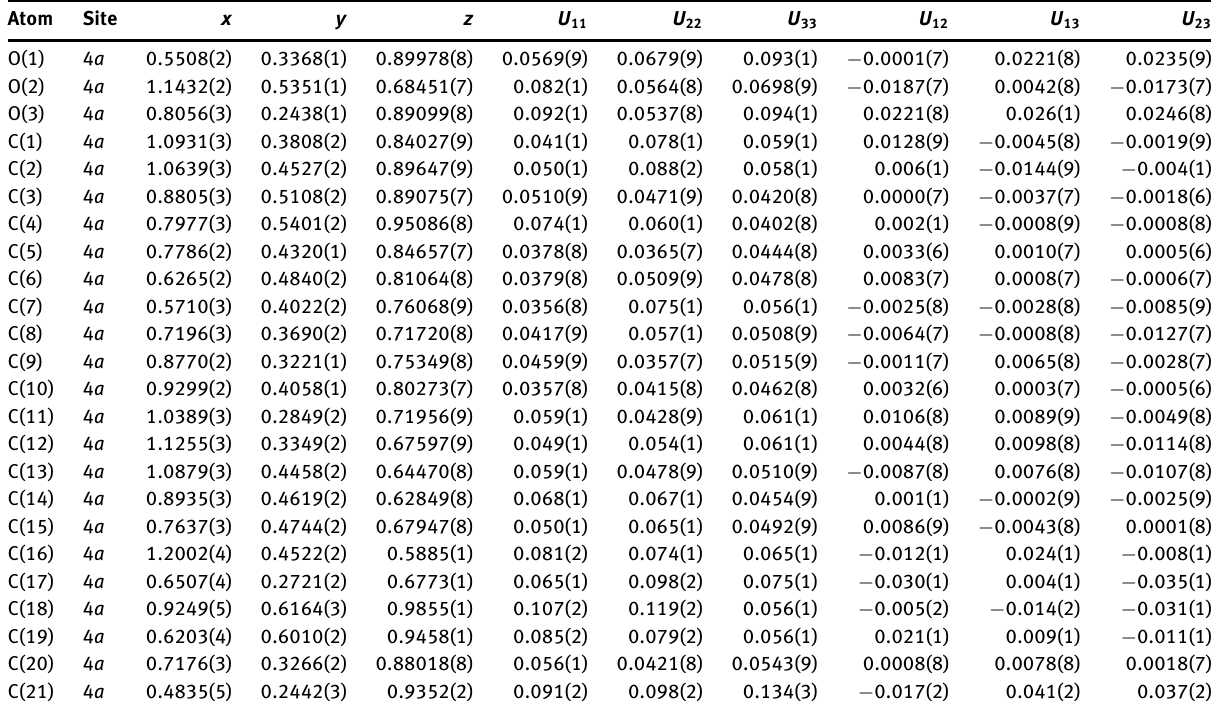
Table 3: Atomic displacement parameters (Å 2